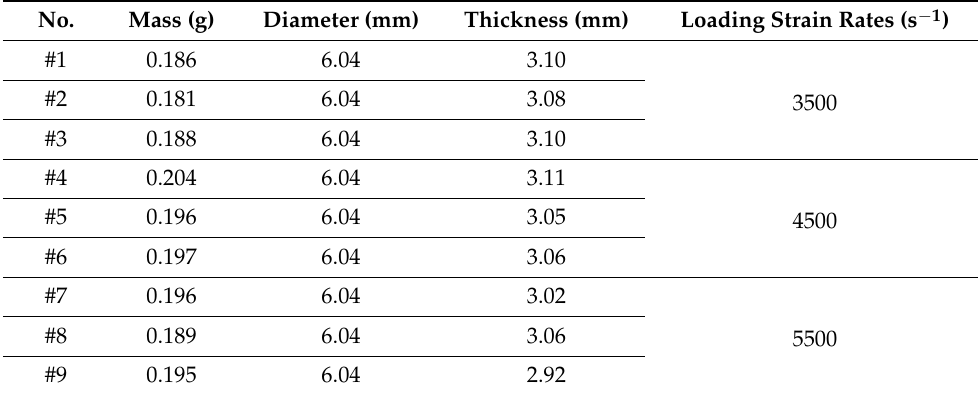
Table 3. The size parameters of samples under different loading strain rates.